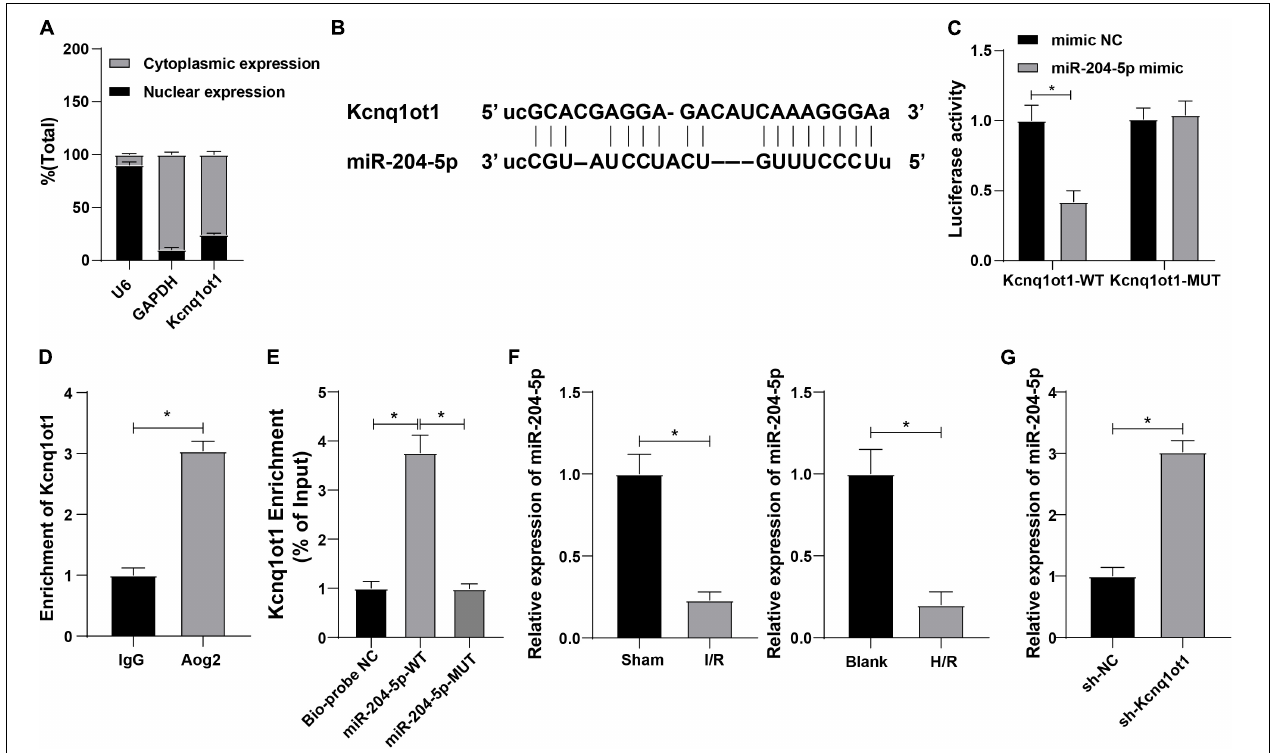
FIGURE 3 | Kcnq1ot1 could competitively bind to miR-204-5p and inhibit miR-204-5p expression. (A) Subcellular localization of Kcnq1ot1 was observed by nuclear/cytosol fractionation assay with GAPDH as cytoplasm marker and U6 as a nuclear marker; (B) binding sites of Kcnq1ot1 and miR-204-5p were predicted through bioinformatics website Starbase; (C) binding relation between Kcnq1ot1 and miR-204-5p was verified by dual-luciferase reporter assay; (D) binding condition of Kcnq1ot1 and miR-204-5p was detected by RIP assay; (E) enrichment of Kcnq1ot1 by miR-204-5p was detected by RNA-pull down; (F) miR-204-5p expression in AKI mouse model and H/R model of HK-2 cells was detected by RT-qPCR; (G) miR-204-5p expression in HK-2 cells transfected with sh-Kcnq1ot1 was detected by RT-qPCR. Data were presented as M ± SD . Comparison between two groups was analyzed using an independent sample t -test, while comparison among multiple groups was analyzed using the one-way ANOVA, followed by Tukey’s post hoc test. * P < 0.05. The experiment was repeated three